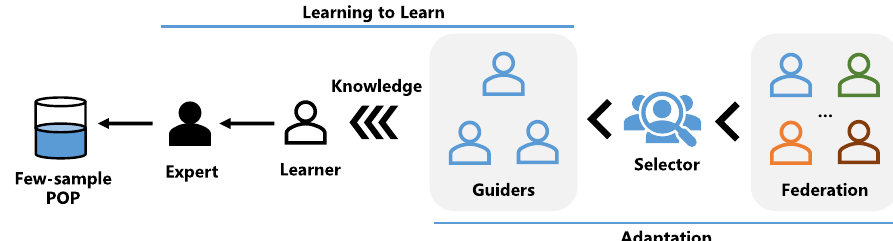
Figure 1. A neat illustration of Adaptation and Learning to Learn